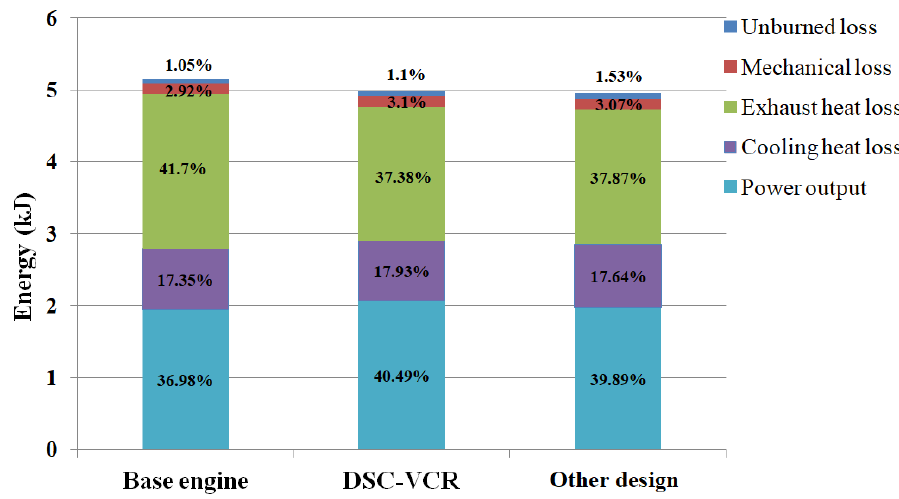
Figure 15. Comparison of energy balance in case 3.